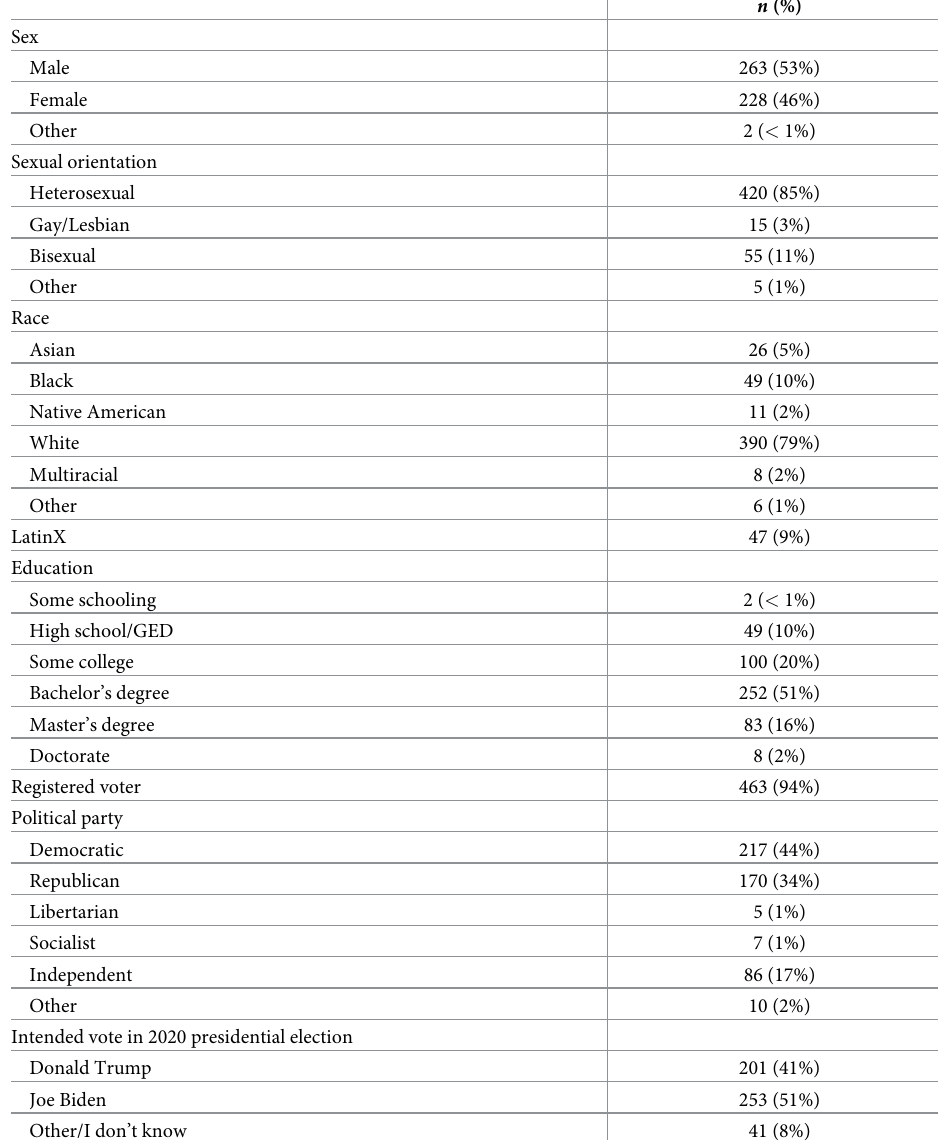
Table 1. Demographic and political preferences of